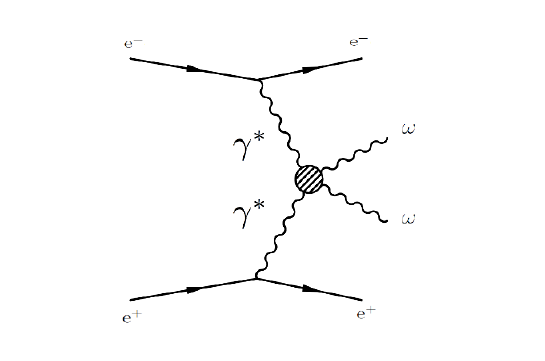
Figure 1 . Feynman diagram for EWSBS-pair photon-induced production at the